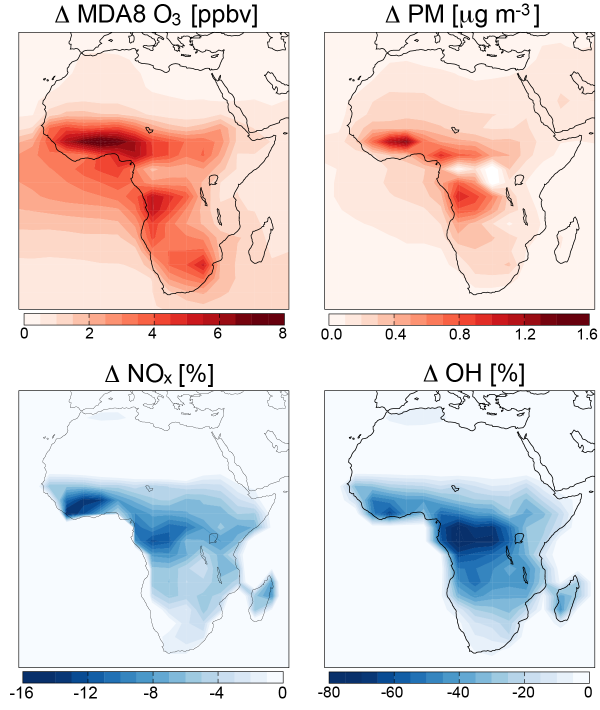
Figure 7. Effect of African isoprene emissions on regional oxidant and particulate matter (PM) concentrations in surface air. Shown are the annual mean differences 1 between GEOS-Chem simulations with and without African isoprene emissions. Isoprene emission is computed using OMI-derived emission